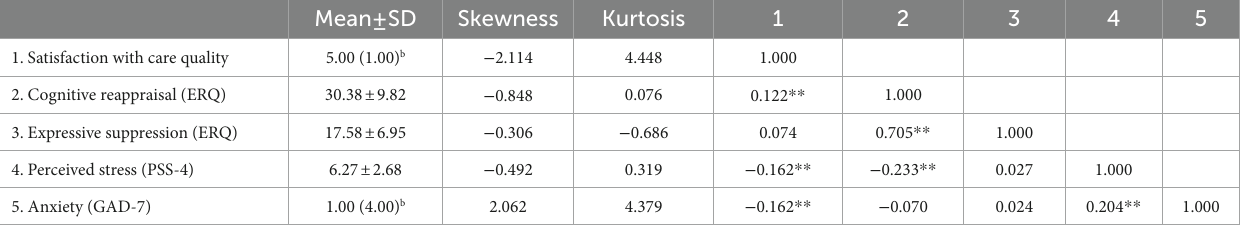
TABLE 2 Correlations of satisfaction with care quality, emotion regulation, perceived stress, and anxiety a .